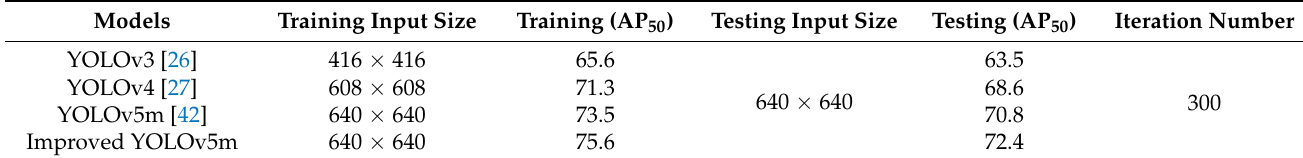
Table 7. Average precision of YOLO models with original wildfire smoke images.